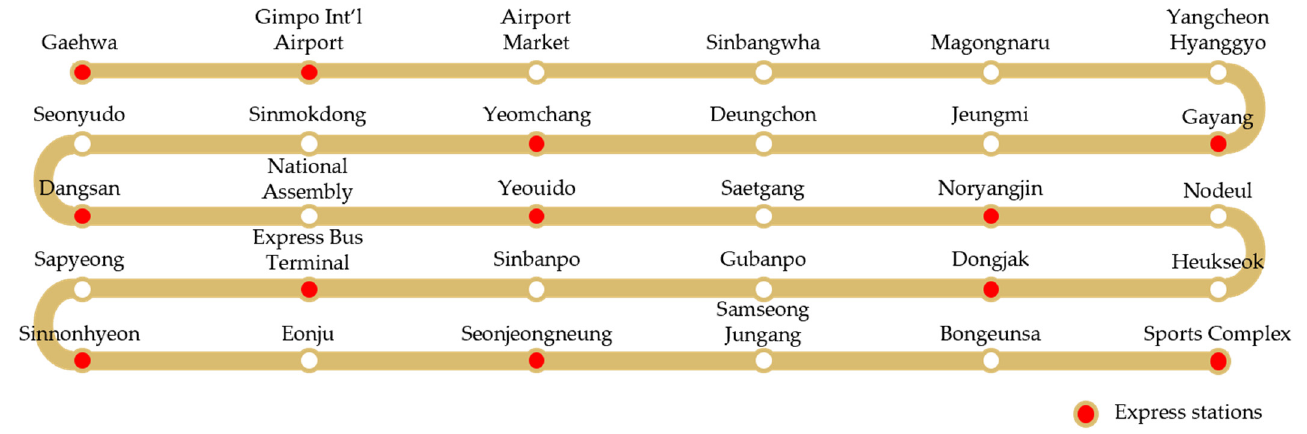
Figure 3. Operation routes for Metro 9 of Seoul Metropolitan City, Korea.